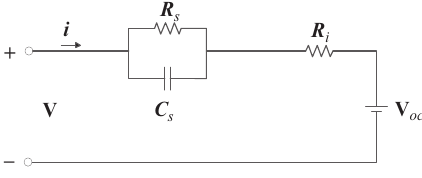
Figure 1. Thevenin equivalent